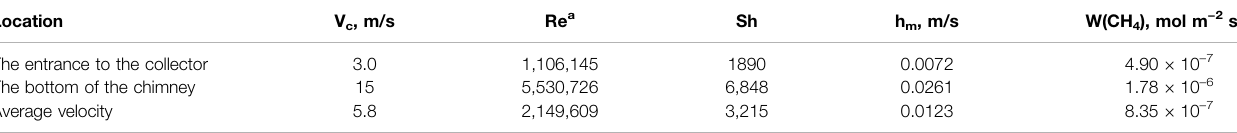
TABLE 5 | Key parameters for 200 MW SUT.